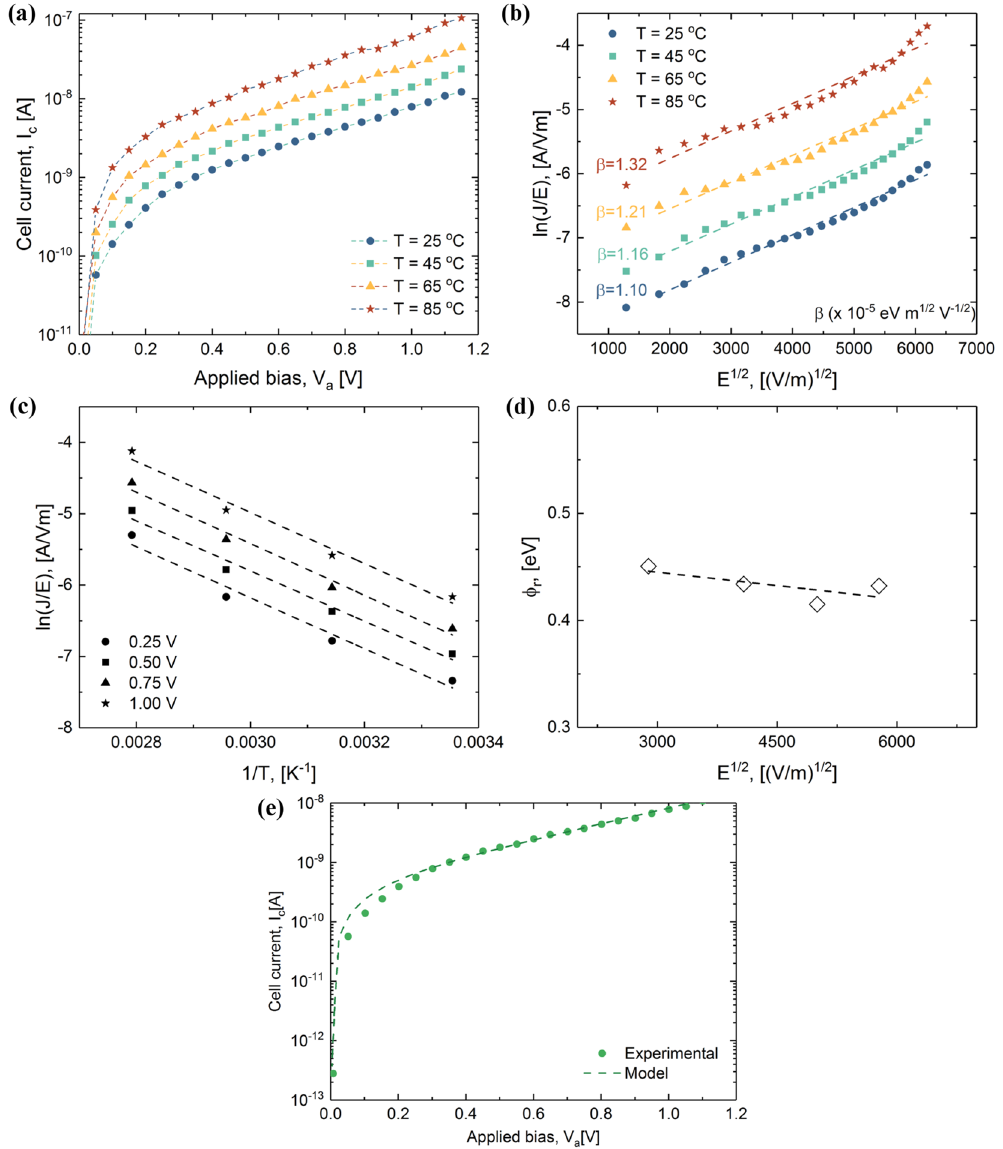
Figure 4. Sub-threshold conduction in GeTe 6 . ( a ): I–V characteristics at four different temperatures, namely 25 °C, 45 °C, 65 °C and 85 °C. ( b ): Poole-Frenkel plot of the sub-threshold current for the temperature ranging from 25 °C to 85 °C. ( c ): Trap depth reduction at various values of the electric field ( d ): Trap depth extraction when no field is applied determined by linear extrapolation ( e ): Modelling of the sub-threshold conduction using Poole-Frenkel model at 25